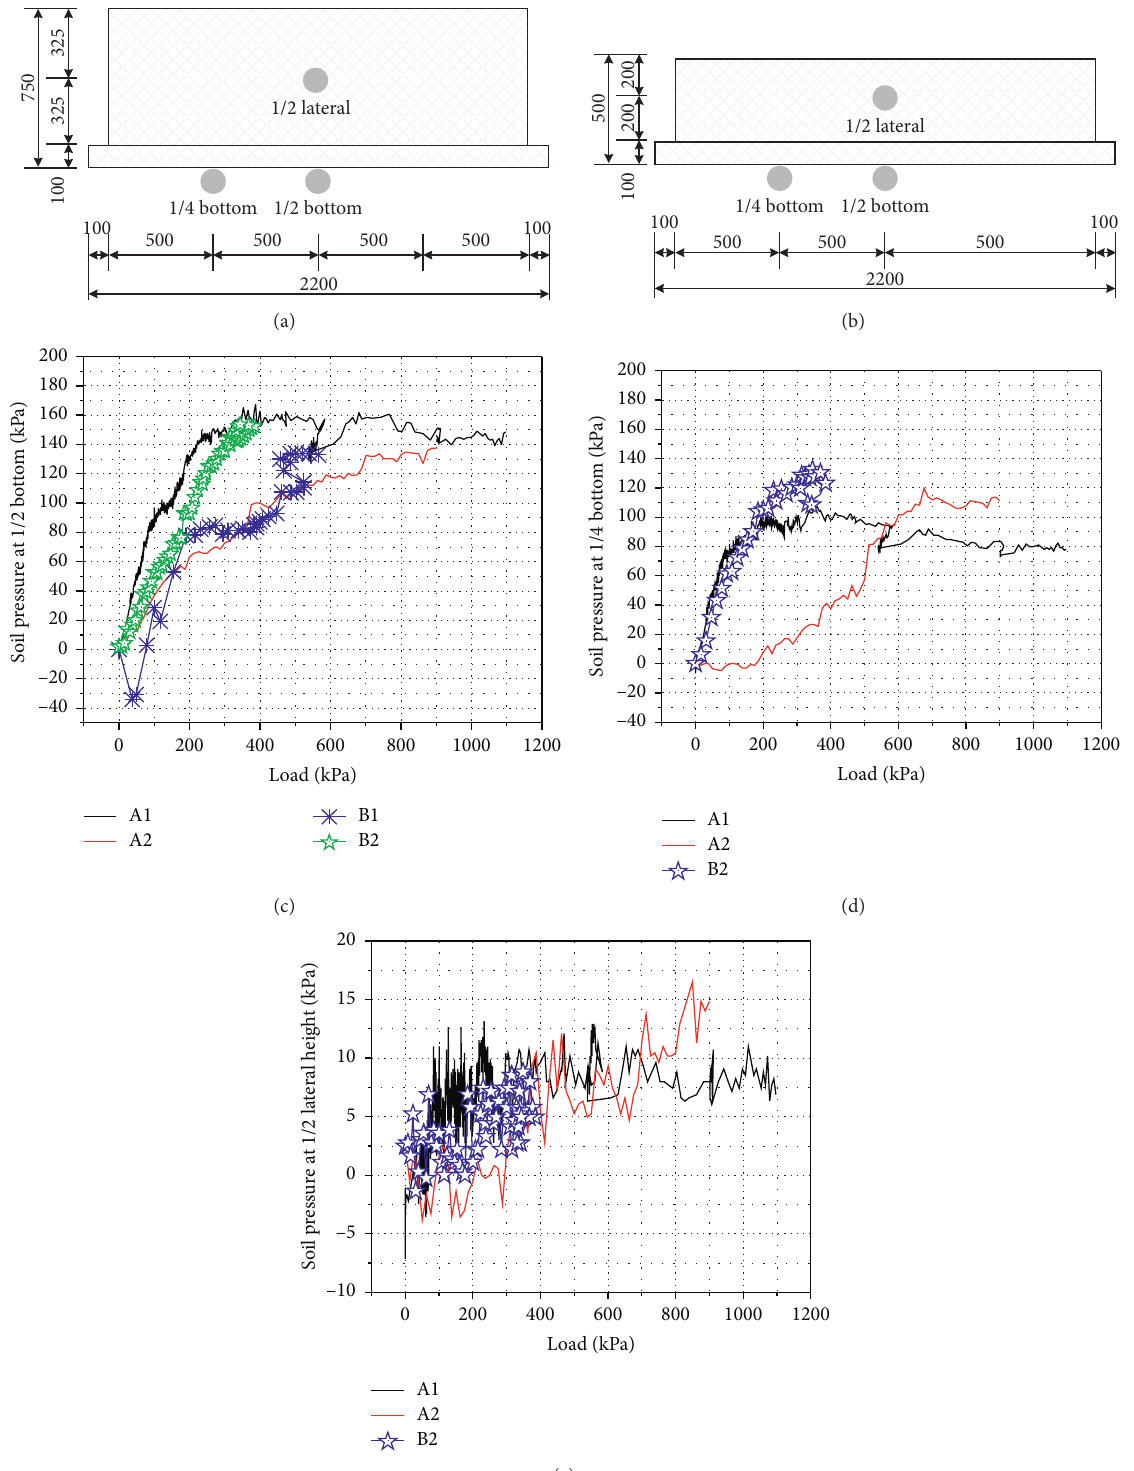
Figure 9: Soil pressure evolution. (a) A-type. (b) B-type. (c) 1/2 bottom. (d) 1/4 bottom. (e) 1/2